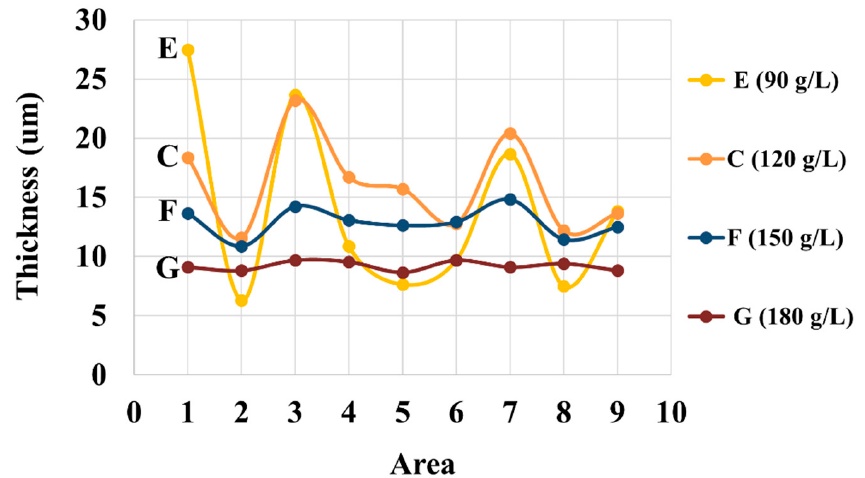
Figure 7. Thickness of coatings at different areas in the corrugated specimens of baths with different NaOH concentrations. Three measurements were made for each sample and small standard deviations below 5% are observed for all data points.